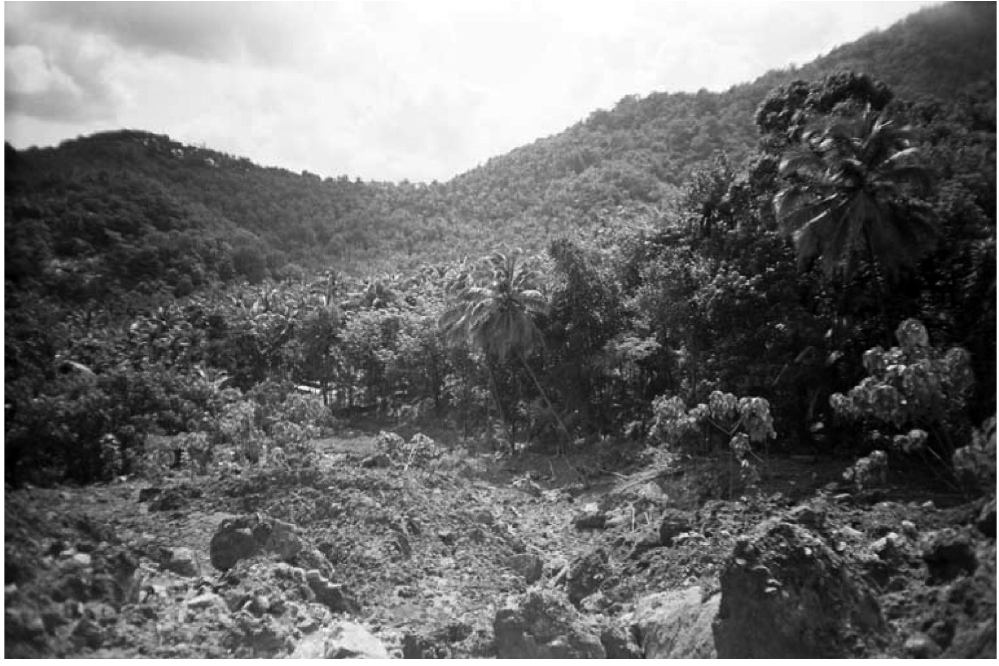
Source: Photos taken during the fieldwork by Sunil D